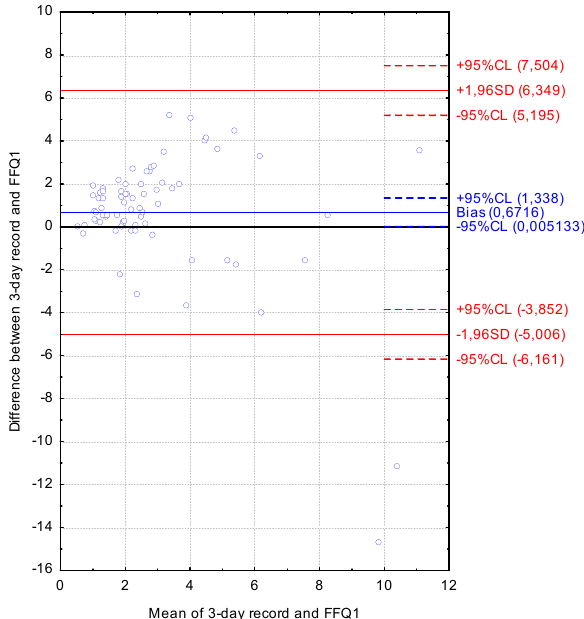
Figure 4. Bland ‐ Altman plot comparing VIDEO ‐ FFQ1 with the three ‐ day dietary record for Vitamin Figure 4. Bland-Altman plot comparing VIDEO-FFQ1 with the three-day dietary record for Vitamin D daily intake (Bland ‐ Altman index of 2.7%). FFQ1—VIDEO ‐ FFQ filled out immediately after D daily intake (Bland-Altman index of 2.7%). FFQ1—VIDEO-FFQ filled out immediately after conducting the three-day dietary